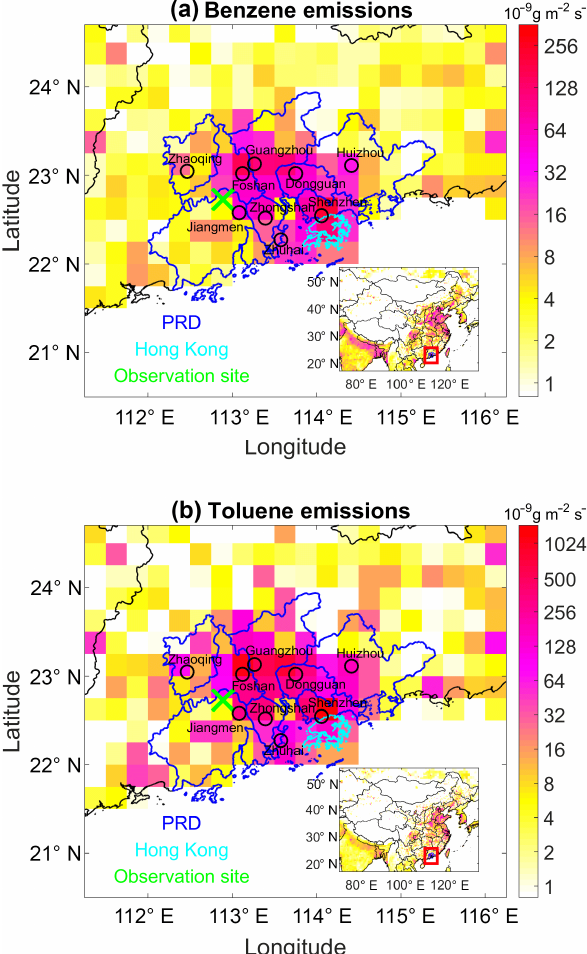
Figure 1. Map of (a) benzene and (b) toluene emissions from the MEIC v1.2 for China and the RCP2.6 for outside China (inset), and that for the PRD and Hong Kong regions (main panels). The PRD region is plotted with dark blue boundary lines, the Hong Kong re- gion with cyan boundary lines. The green cross indicates the loca- tion of the Heshan observation site. The hollow black circle indi- cates the location of the major cities in the